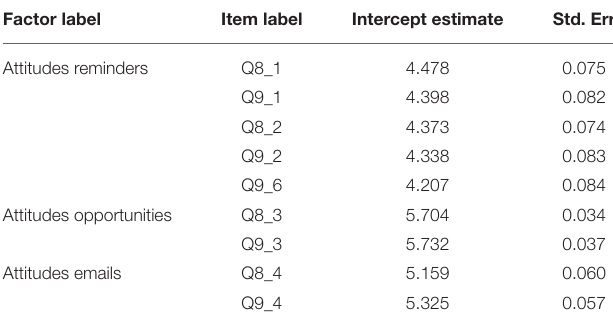
TABLE 2 | Item intercepts of the dependent variables included in the structural equation